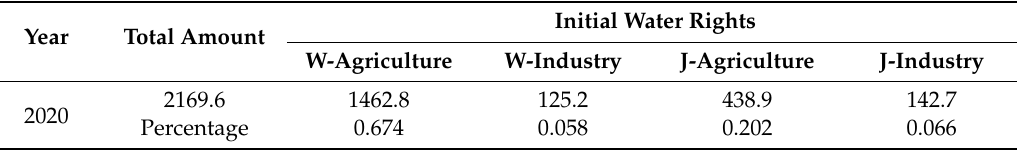
Table 7. Forecasted initial water rights allocation for the primary and secondary industries of the Shiyang River Basin in 2020 (million m 3